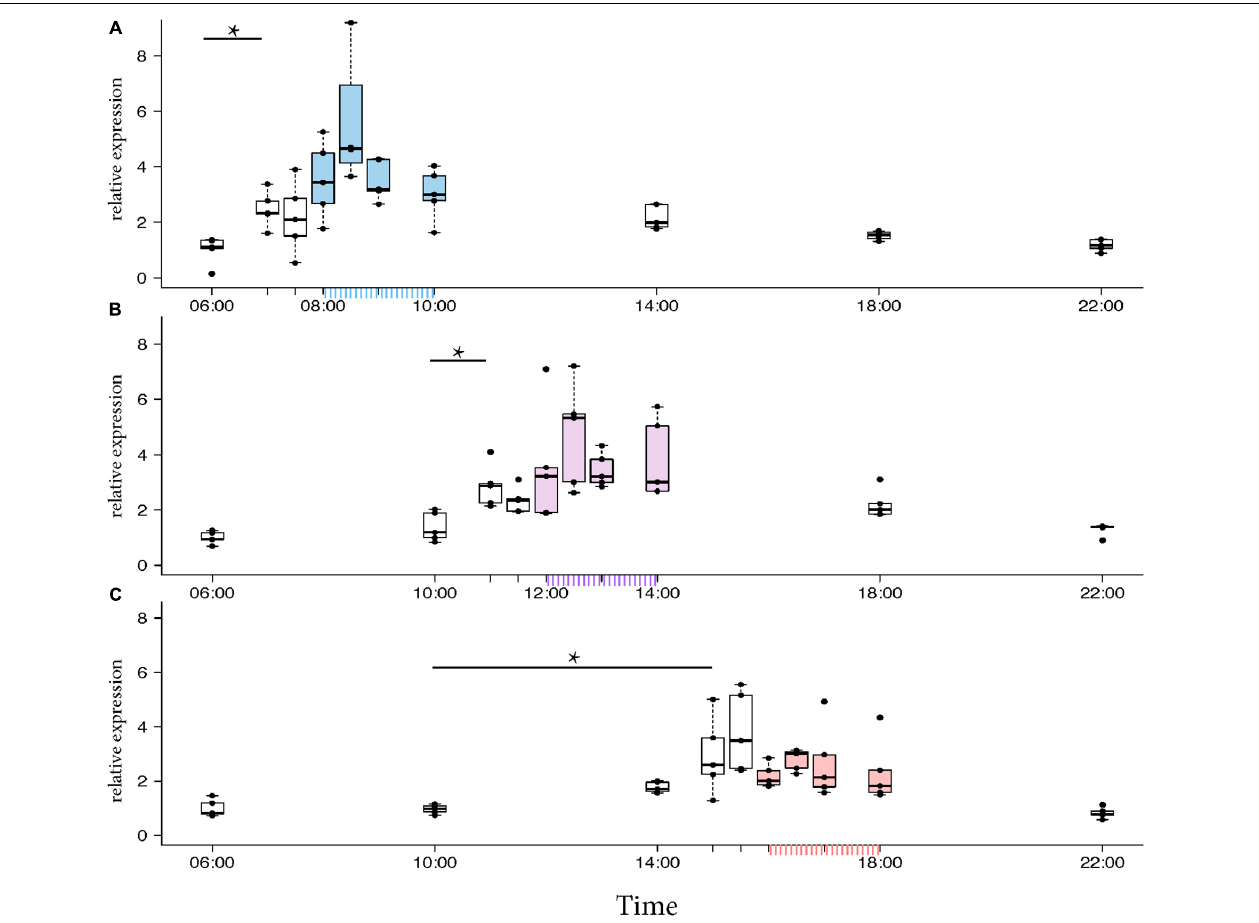
FIGURE 4 | Egr-1 expression when the bees were prevented from flying out using “artificial rain” setup. (A) Bees that were trained from 08:00 to 10:00, already showed significant up-regulation of Egr-1 by 07:00 and remained up-regulated till the end of training time with a peak at 08:30. The mRNA levels started to decline at 09:00 and was reduced significantly by 14:00 and remained low for the rest of the day. (B) Bees that were trained from 12:00 to 14:00, showed significant up-regulation by 11:00 with a peak at 12:30. The expression declined thereafter and was significantly low by 18:00. (C) Bees that were trained from 16:00 to 18:00 showed an up-regulation trend already by 14:00, although not significant. mRNA levels were significantly increased by 15:00 with a peak at 15:30 which started to decline thereafter, differing from the trends seen in morning and afternoon trained bees. Data shown as relative expression changes compared to 06:00 in the form of box-plots with individual data-points delineated, n = 5. KW-test with Dunn’s (“bh” method) multiple comparison was done on each experiment, p -values are shown in Tables 1 – 3 ,